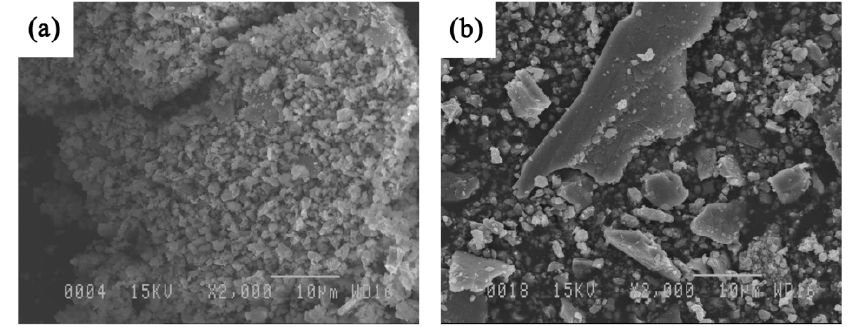
Figure 14. Microscopic morphologies of the wear debris of the Fe 3 Al ‐ TiB 2 composite coatings worn at sliding speed of ( a ) 0.04 and ( b ) 0.3 m s − 1 .